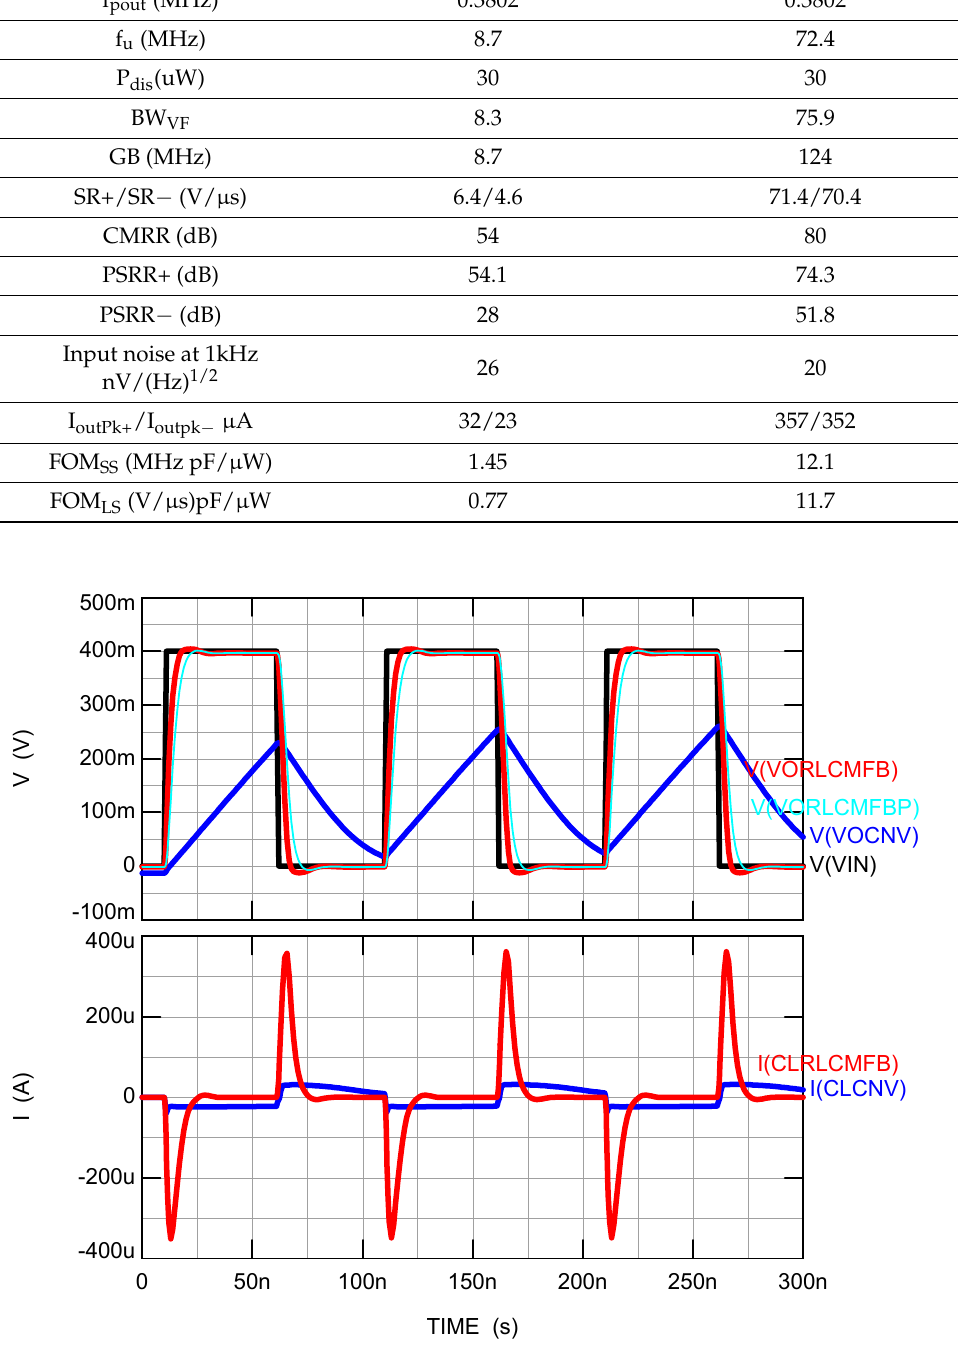
Figure 7. CMRR response of circuits of Figure 3.